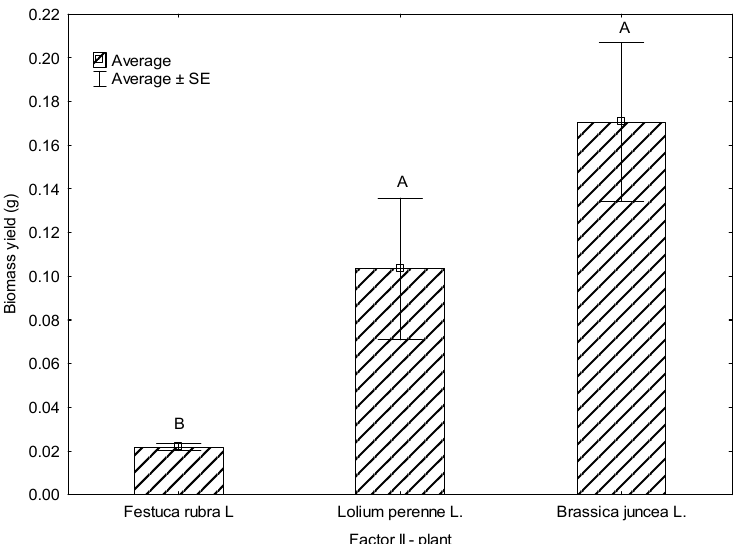
Figure 13. Under ‐ ground biomass (root) yield of Festuca rubra L., Lolium perenne L. and Brassica juncea L. from a pot experiment carried out for unburnt soil, burnt soil and burnt soil supple ‐ mented with different amendments. Average values of plant biomass (n = 3) ± SE are presented; different small letters indicate significant differences between individual plants within one vari ‐ ant. Different uppercase letters in bold indicate significant differences in average (n = 9) plant bio ‐ mass yield between individual variants.